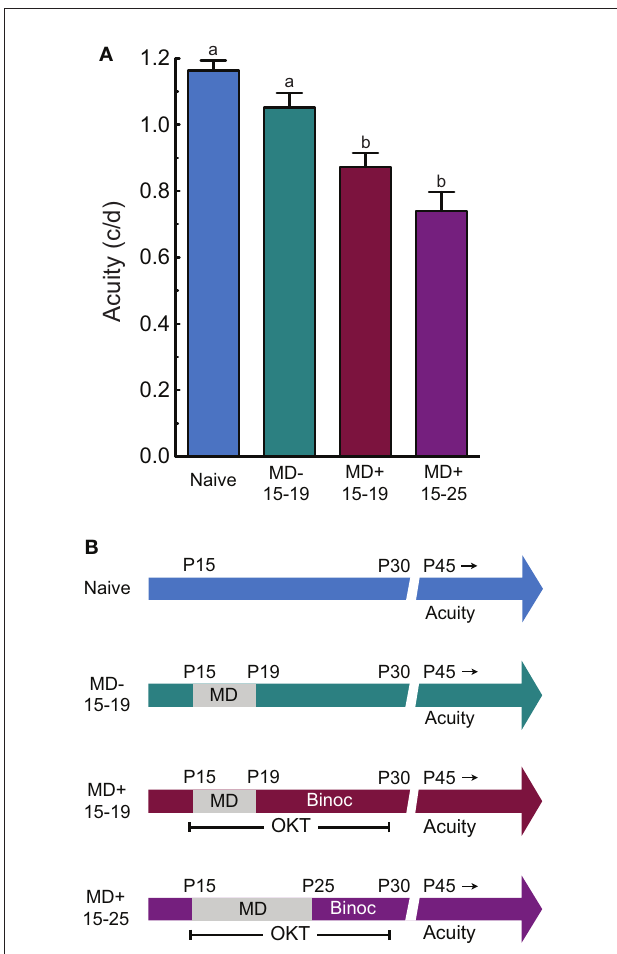
Figure 4 | experience-enabled loss of OKT is accompanied by amblyopia. (A) MD on its own in infancy (MD − 15–19) did not lead to reduced acuity in adulthood, relative to naive controls (Naive). However, adult acuity was lower in groups with MD and OKT experience up to P19 (MD + 15–19; i.e., Figure 1D ) or P25 (MD + 15–25; i.e., Figure 1B ). a vs. b indicates statistical significance, p < 0.05. (B) Experiential timeline and visual testing schedule for groups in (A) . OKT testing was monocular during the MD and Binocular (Binoc) after, in MD +